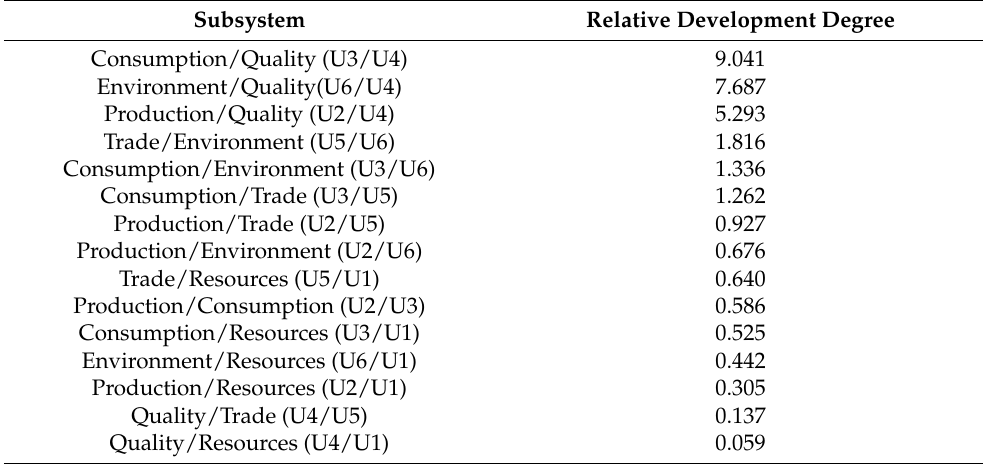
Table 5. Relative development degree of China’s beef cattle industry